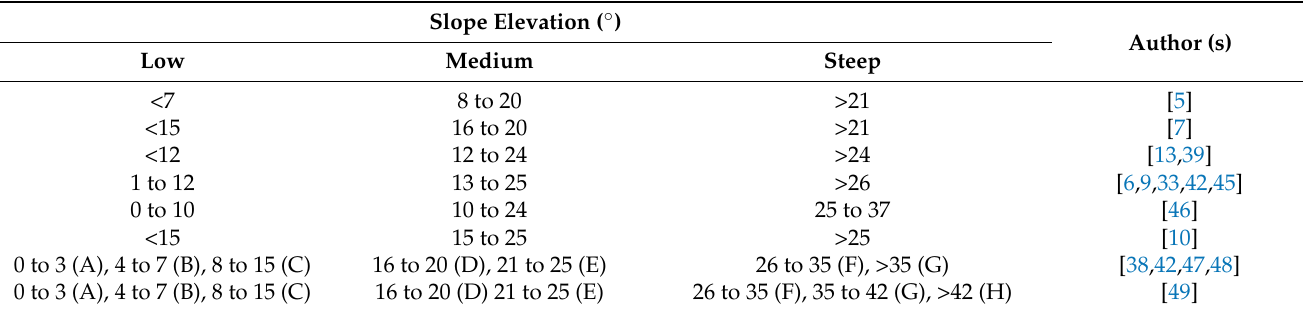
Table 2. Published proportions of the three slope classes (low, medium, and steep) as percentage of the total hill country farm in New Zealand. Slope Class Proportion (%) Low